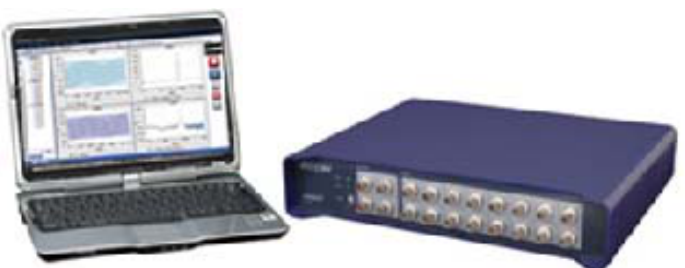
Figure 9. Vibration data acquisition